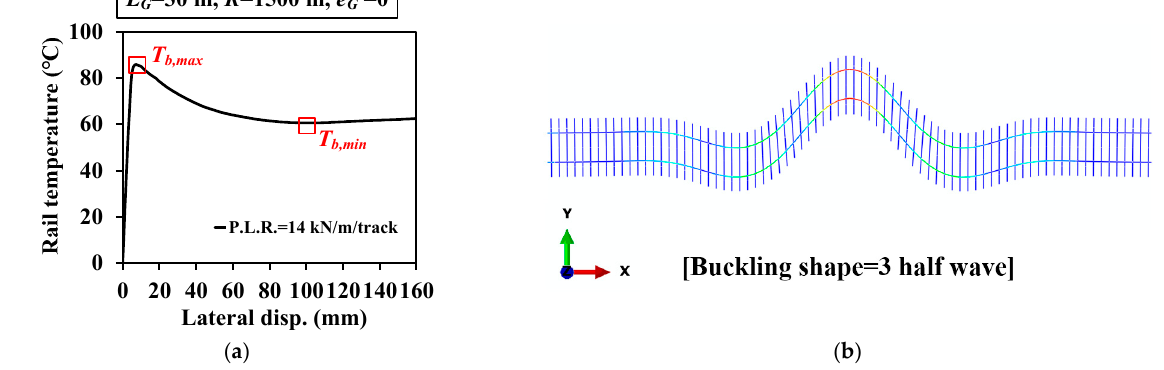
Figure 11. Analysis results ( R = 1500 m): ( a ) rail temp. vs. lateral disp.; and ( b ) buckling shape.